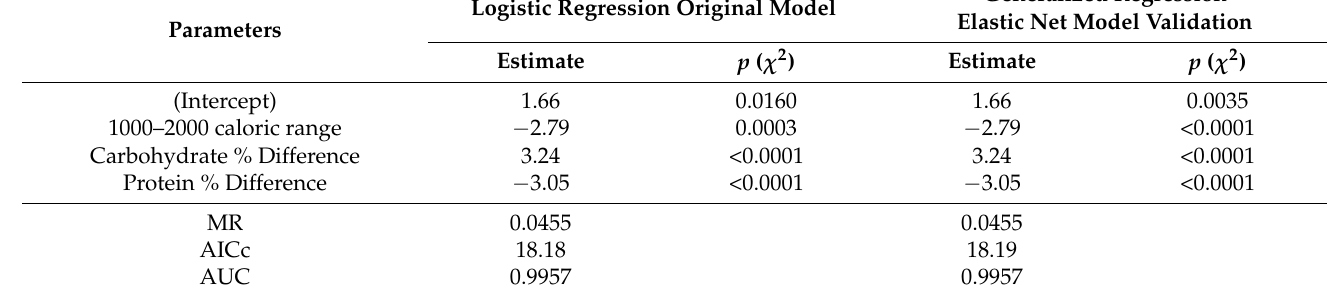
Table 3. Significant factors contributing to the differences between the mobile application and Food Frequency Questionnaire on total calories.